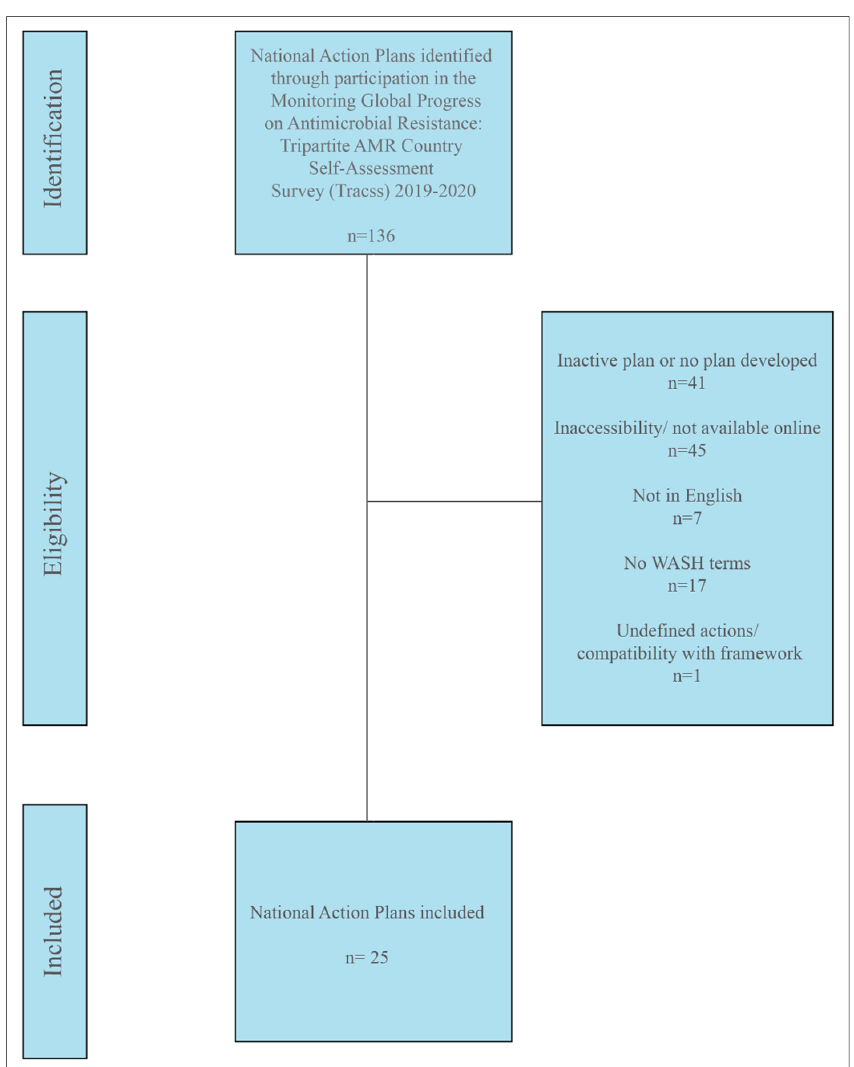
Figure 13. Prisma diagram reflecting the NAP case study screening process.